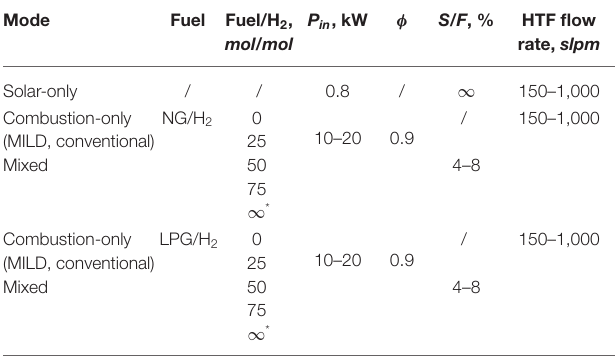
TABLE 1 | Experimental operating conditions for all the modes of operation investigated by Chinnici et al.